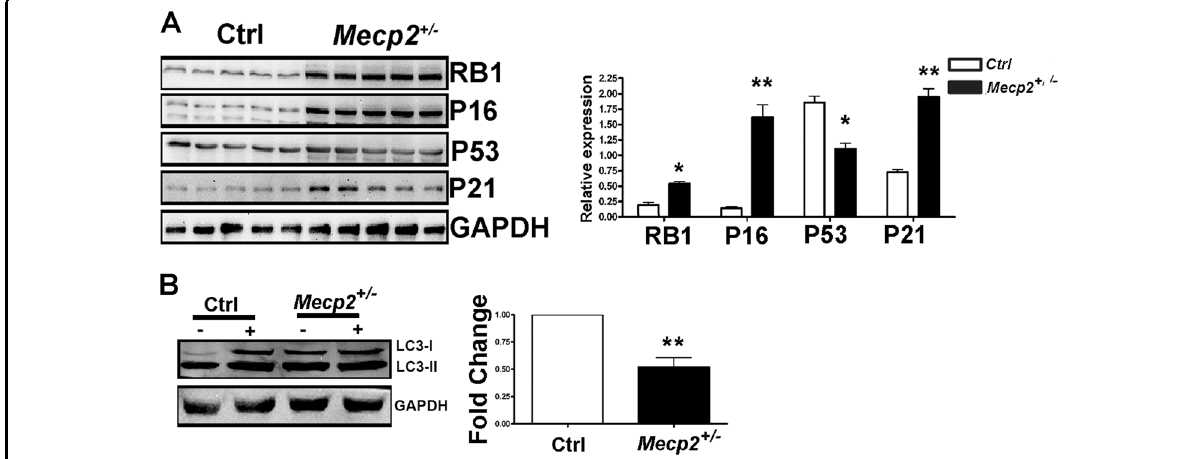
Fig. 2 Western blot analysis of cell cycle-related pathways and autophagic fl ux. a The picture shows the expression levels of RB1, P16, P53, and P21 in Mecp2 + / − and control samples. For every protein, three biological replicates are shown. GAPDH was used as a loading control. The graph shows mean expression levels (±SD, n = 5 biological replicates, * p < 0.05, ** p < 0.01). b Western blot detection of LC3-I and LC3-II in Mecp2 + / − and control NSCs. The cells were grown as fl oating neurospheres and then harvested for western blot analysis. The detection of autophagic fl ux was performed by treating cultures with 100 nM of Ba fi lomycin A1, an inhibitor of lysosomal degradation, or with PBS. The LC3-I and II band intensities were normalized with GAPDH. The picture illustrates a representative western blot we analyzed to determine the autophagic fl ux. Autophagic fl ux (AF) for LC3-II was calculated as follows: Mecp2 + / − NSC AF = ( Mecp2 + / − sample in Bafylomycin A1) − ( Mecp2 + / − sample in PBS), Control NSC AF = (Control sample in Bafylomycin A1) − (Control sample in PBS). The change in autophagic fl ux ( Δ AF) between Mecp2 + / − and the control NSCs was calculated as Δ AF = Mecp2 + / − NSC AF − Control NSC AF. The graph shows AF changes in Mecp2 + / − NSCs compared with the control cultures. The data in the control were set as equal to 1 ( n = 5 biological replicates; ** p <